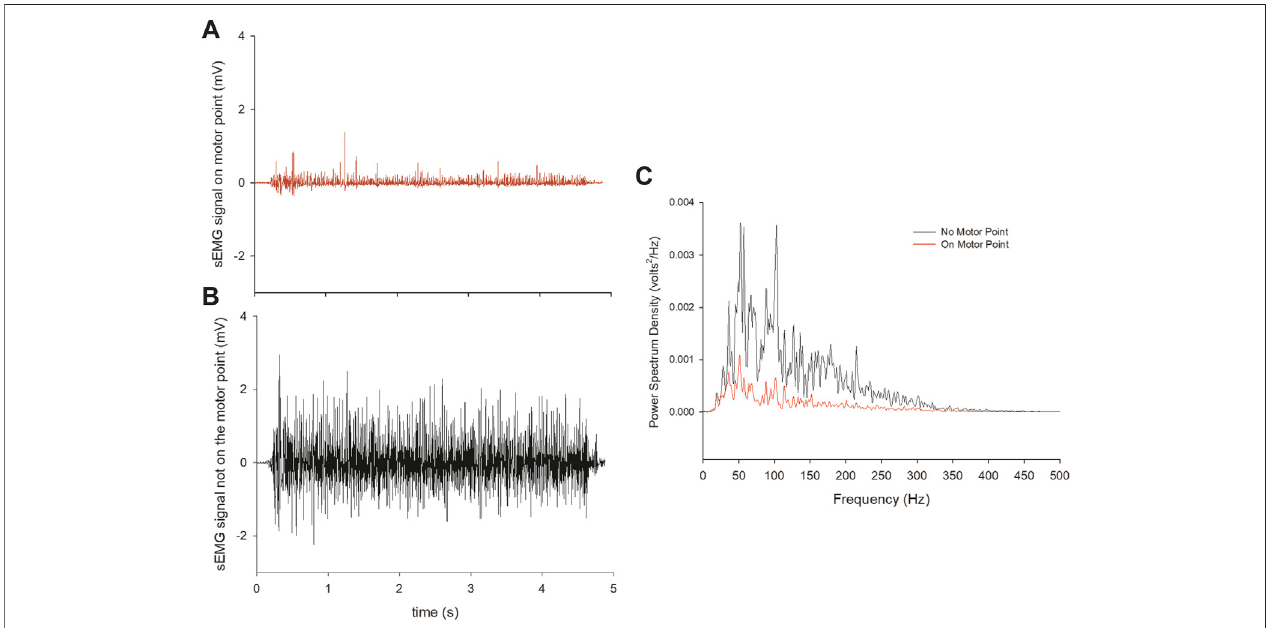
FIGURE 2 | An example from a representative participant of the sEMG signal deriving from an appropriate (A) or non-appropriate (B) electrode placement. The power spectrum density is also shown for the two cases (C) .